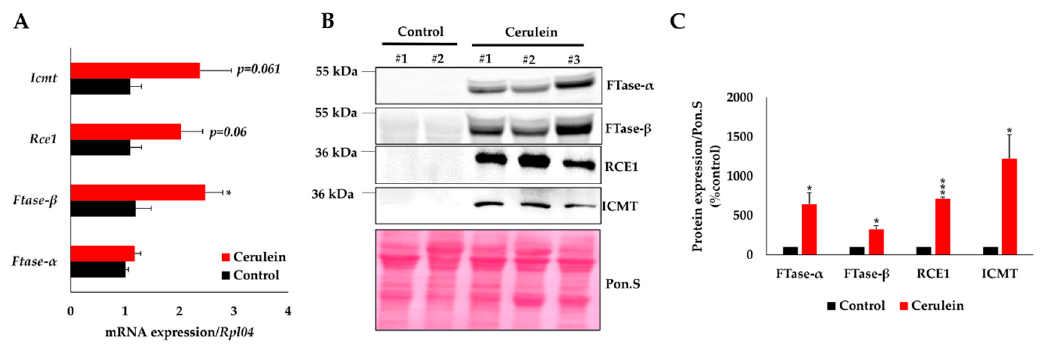
Figure 6. Pancreas inflammation induces protein expression of enzymes involved in the prenylation pathway. ( A ) RTqPCR analysis on FACS-sorted acinar cells from Ela-Kras G12D /+ mice treated ( n = 6) or not ( n = 6) with cerulein for 3 days (*: p < 0.05). ( B ) Western blot analysis on pancreas lysates from Ela-Kras G12D /+ mice treated ( n = 3) or not ( n = 3) with cerulein for 1 week. ( C ) Densitometry quantifications of blots shown in panel B. Data are mean ± SEM. Statistical significance was tested using student t -test (*: p < 0.05; ***: p < 0.001).